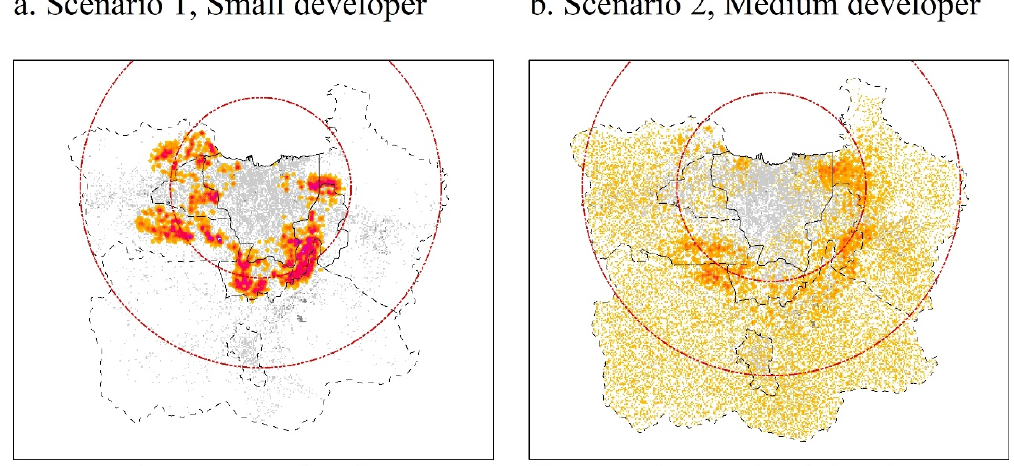
Figure 4. New urban areas at t = 216 months (or 18 years) generated from the ABM after 100 simulations under different scenarios. The first and second radial lines represent 25 km and 50 km distance to Jakarta’s CBD, respectively. The diverse spatial patterns of simulated urban form under the five development scenarios could be quantified using landscape matrices, including Edge Density (ED), Clumpiness index (CLUMPY) and Interspersion and Juxtaposition index (IJI) [54,55]. It can be confirmed that urban areas developed by small developers display a small and disconnected shape as indicated by high